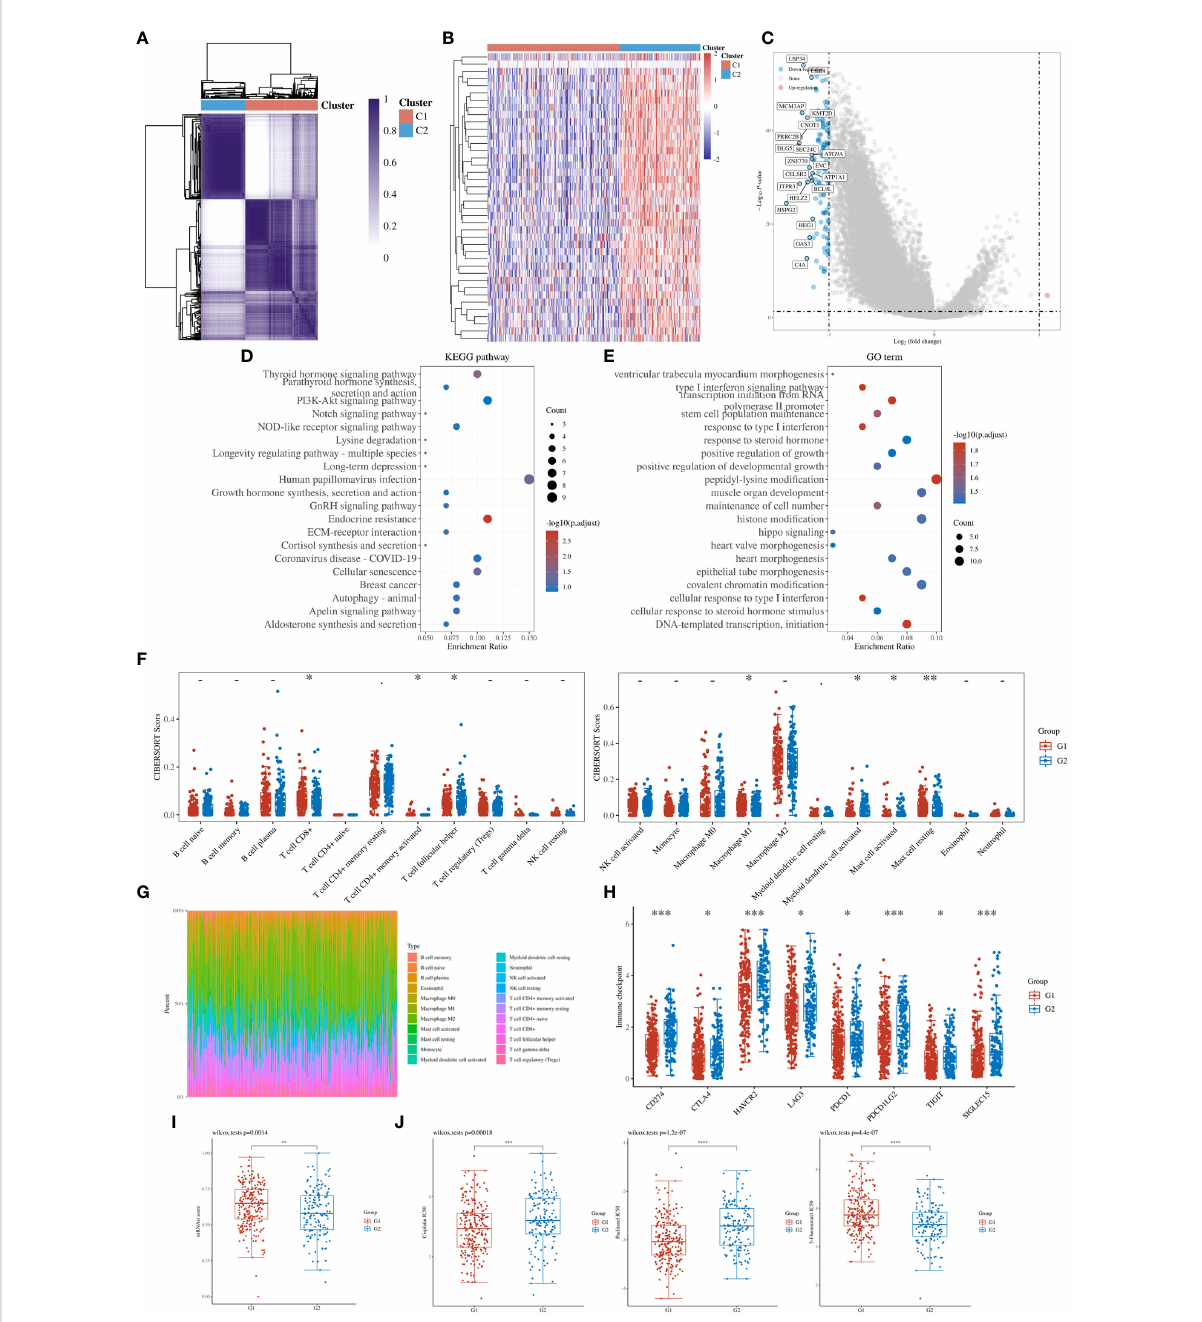
FIGURE 5 Strati fi cation of OSCs based on the expression of BRDs. (A) Heatmap depicting consensus clustering solution for BRDs based on the TCGA database OSC dataset. (B) Heatmap of DEGs based on Cluster 1 compared to Cluster 2. (C) . Volcano plot of DEGs. (D) KEGG enrichment of DEGs. (E) GO enrichment of DEGs. (F) Immune cell expression distribution for Cluster 1 compared to Cluster 2. (G) The percentage abundances of different immune cell types in each sample. (H) Heatmap of immune checkpoint-related gene expression for Cluster 1 and Cluster 2. (I) The stemness score for Cluster 1 and Cluster 2. (J) The drug sensitivity analysis for cisplatin, paclitaxel, and 5-Fu in Cluster 1 and Cluster 2. (G1 is the group of the Cluster 1 for OC patients. G2 is the group of the Cluster 2 for OC patients.) *p < 0.05; **p < 0.01; ***p < 0.001; ****p <